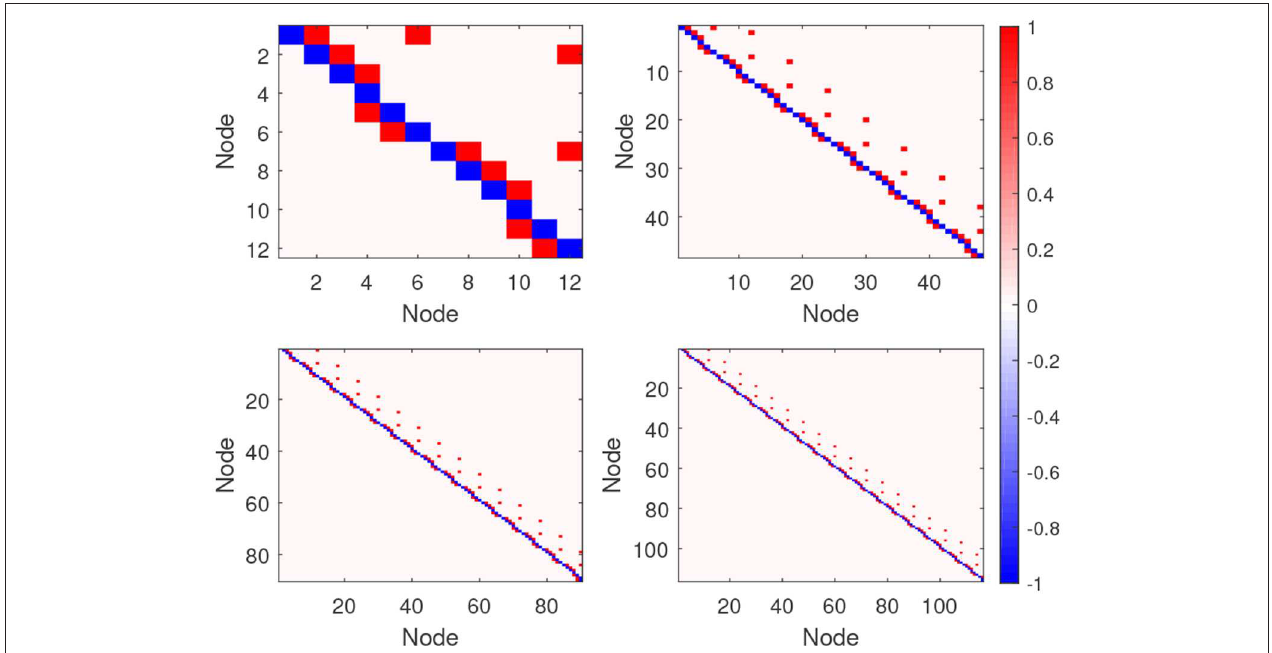
FIGURE 4 | The connection matrix of the four ground-truths on the four simulation datasets: The upper left is Sim1, upper right is Sim2, lower left is Sim3, and lower right is Sim4. For each network graph the corresponding connection matrix is shown, where an element in the upper diagonal of the matrix (red gird) implies a directed connection from a lower-numbered node to a higher-numbered one, and an element in the lower diagonal of the matrix (red gird) implies a directed connection from a higher-numbered node to a lower-numbered one.